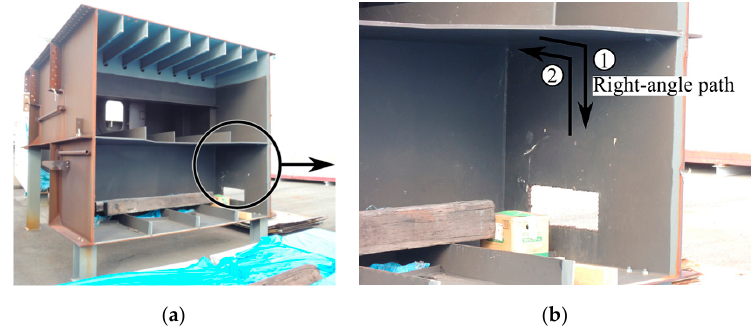
Figure 9. Box girder of the bridge. ( a ) External view; ( b ) enlarged view.